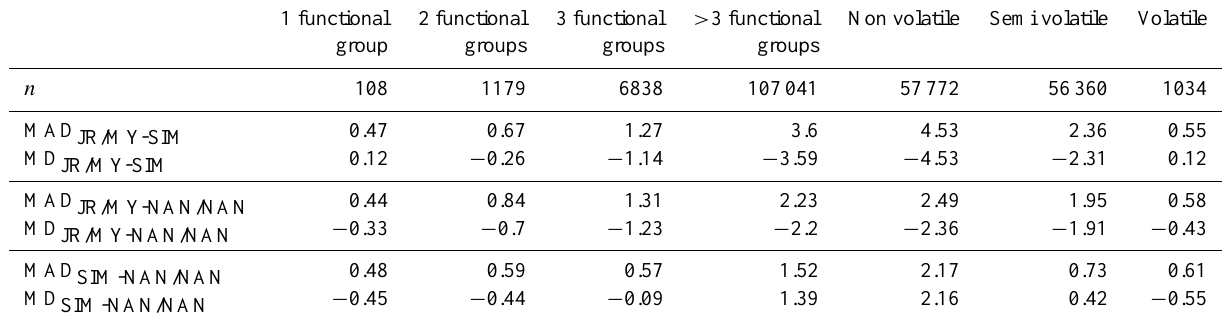
Table 2. Mean average differences (MAD) and mean differences (MD) between JR/MY–SIM, JR/MY-NAN/NAN, SIM-NAN/NAN, for (1) mono-functional, di-functional, tri-functional and multifunctional species and (2) for non volatile, semi-volatile and volatile species. 1 functional 2 functional 3 functional > 3 functional Non volatile Semi volatile Volatile group groups groups groups n